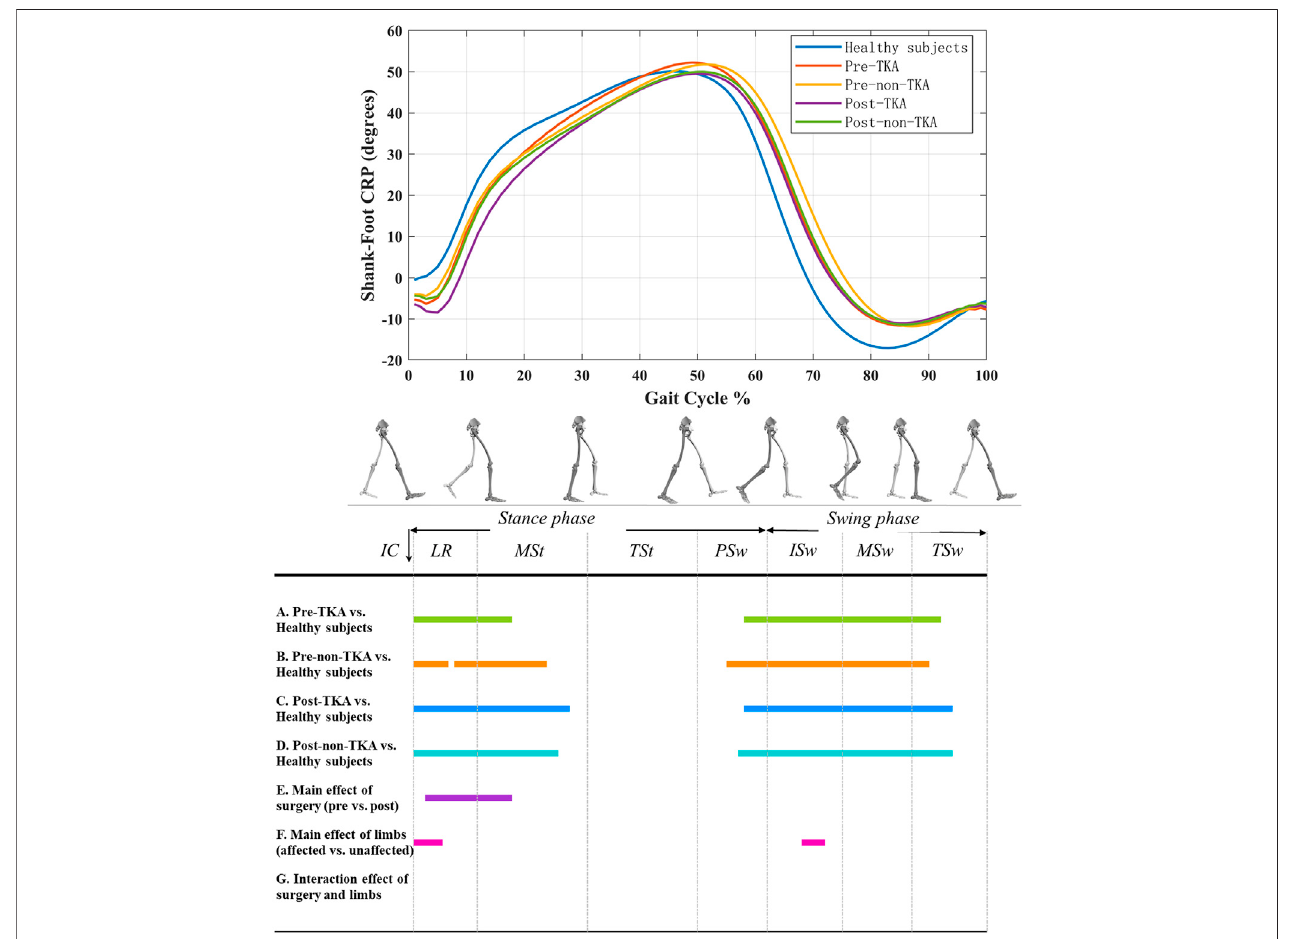
FIGURE2| Shank-footCRPcurvesinpatientsbeforeandafterTKAandhealthysubjects.Apositivevalueindicatesthatshankleadsoverfoot,andanegativevalue indicates that foot leads over shank.